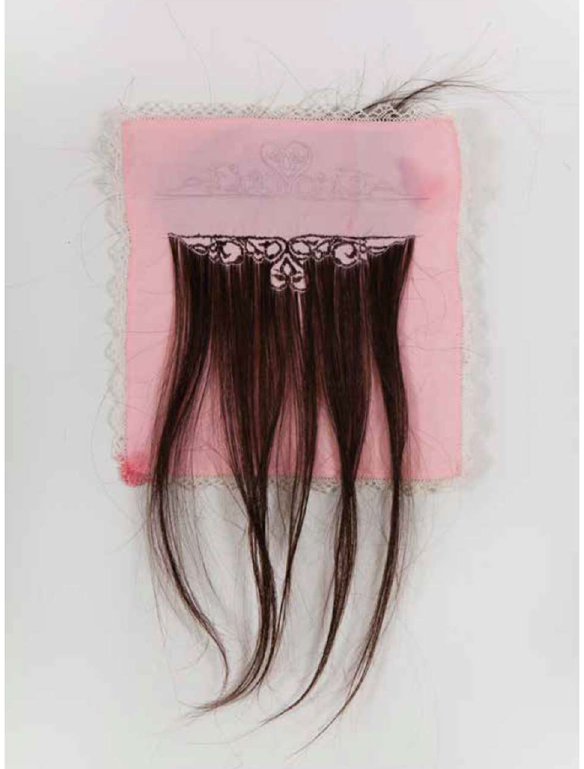
Figure 13. Fatima Abu-Roomi, Bridal Kerchief , 2015–2016, hair, kerchief and lace, 22 × 40 cm.